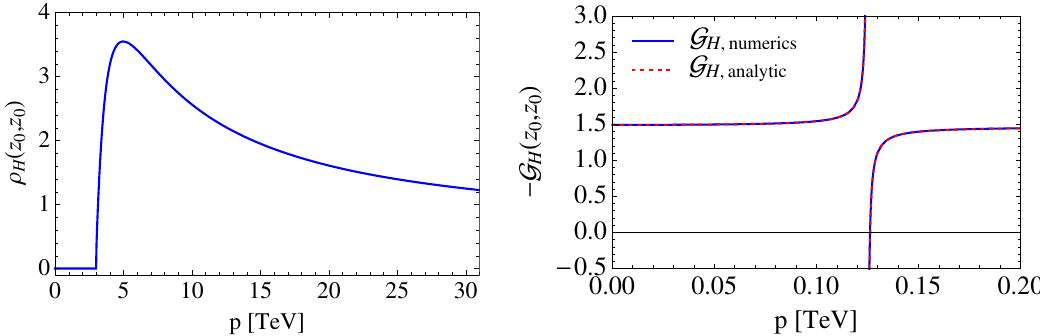
Figure 9 . Left panel: spectral density (cid:26) H ( z 0 ; z 0 ; p ) for a continuum Higgs boson. Right panel: Green’s function, G H ( z 0 ; z 0 ; p ), for the Higgs. We display in solid (blue) line the numerical compu- tation using eq. (5.82), and in dotted (red) line the analytical result from eq. (5.90). We have used A 1 = 35, c = 1, (cid:26) = 2 TeV, a = 2 : 4 and M 0 = 0 : 5 (cid:1) ka . The pole of the Green’s function is located at p = 0 : 125